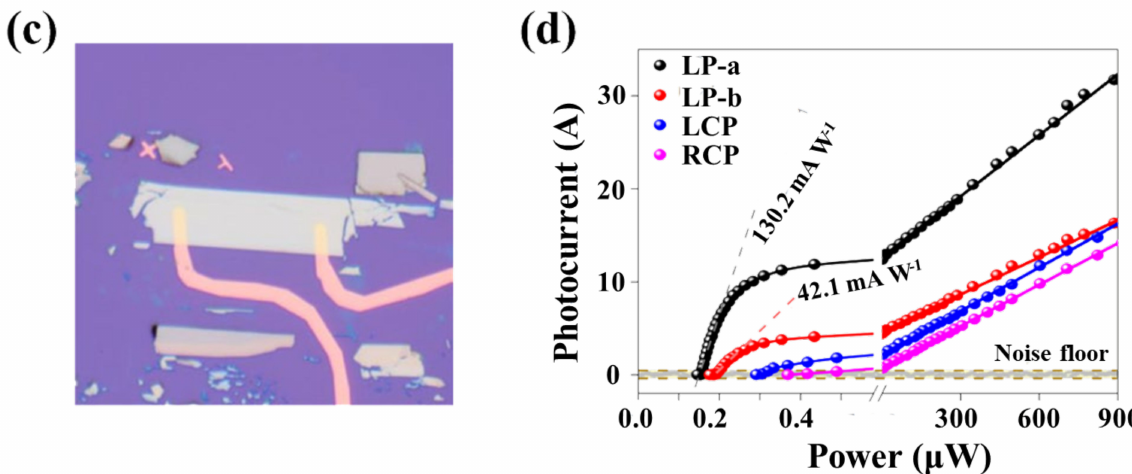
Figure 6. Topology enhancement effect. ( a ) Vector plot of the Berry curvature of Weyl semimetals in momentum space. ( b ) The integrand of the effective third-order optical conductivity tensor is shown along contours of fixed electron energy in momentum space (k x –k y ) for TaIrTe 4 . ( c ) Optical microscopy image of the device. ( d ) Light-power dependence of the photocurrent at 4 µ m incident wavelength in a FET based on TaIrTe4, a type-II Weyl semimetal. Reproduced with permission from [82,83].Copyright Nature Publishing Group, 2016,